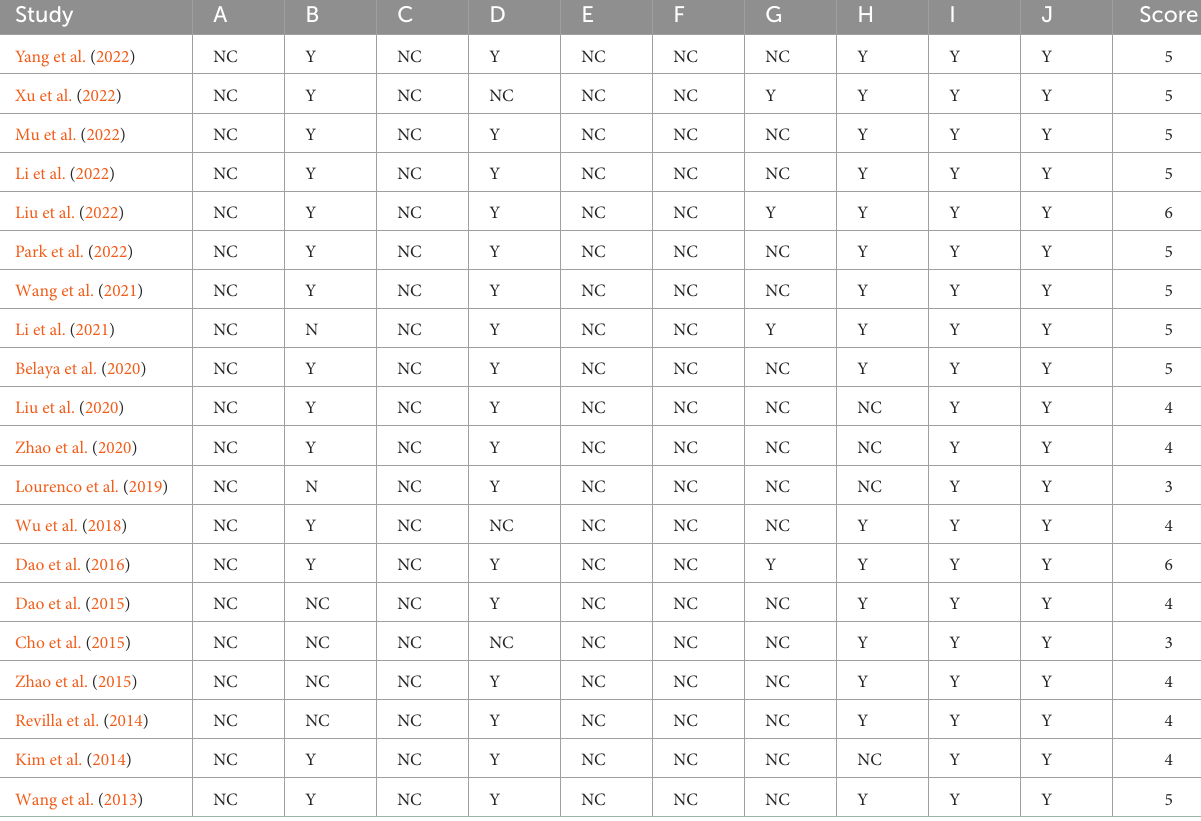
TABLE 2 The methodological quality assessments of 20 included